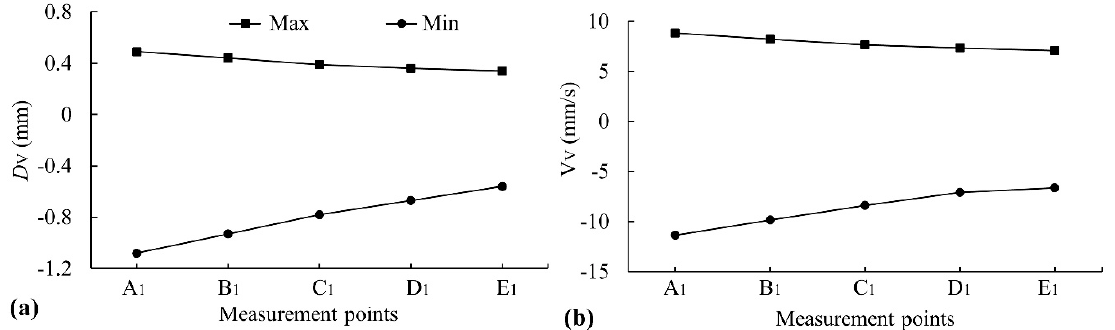
Figure 9. Maximum and minimum value of the D V and V V of five measurement points (A 1 , B 1 , C 1 , D 1 and E 1 ) in Wall_1 of T2: ( a ) maximum and minimum value of the D V ; ( b ) maximum and minimum value of the V V .